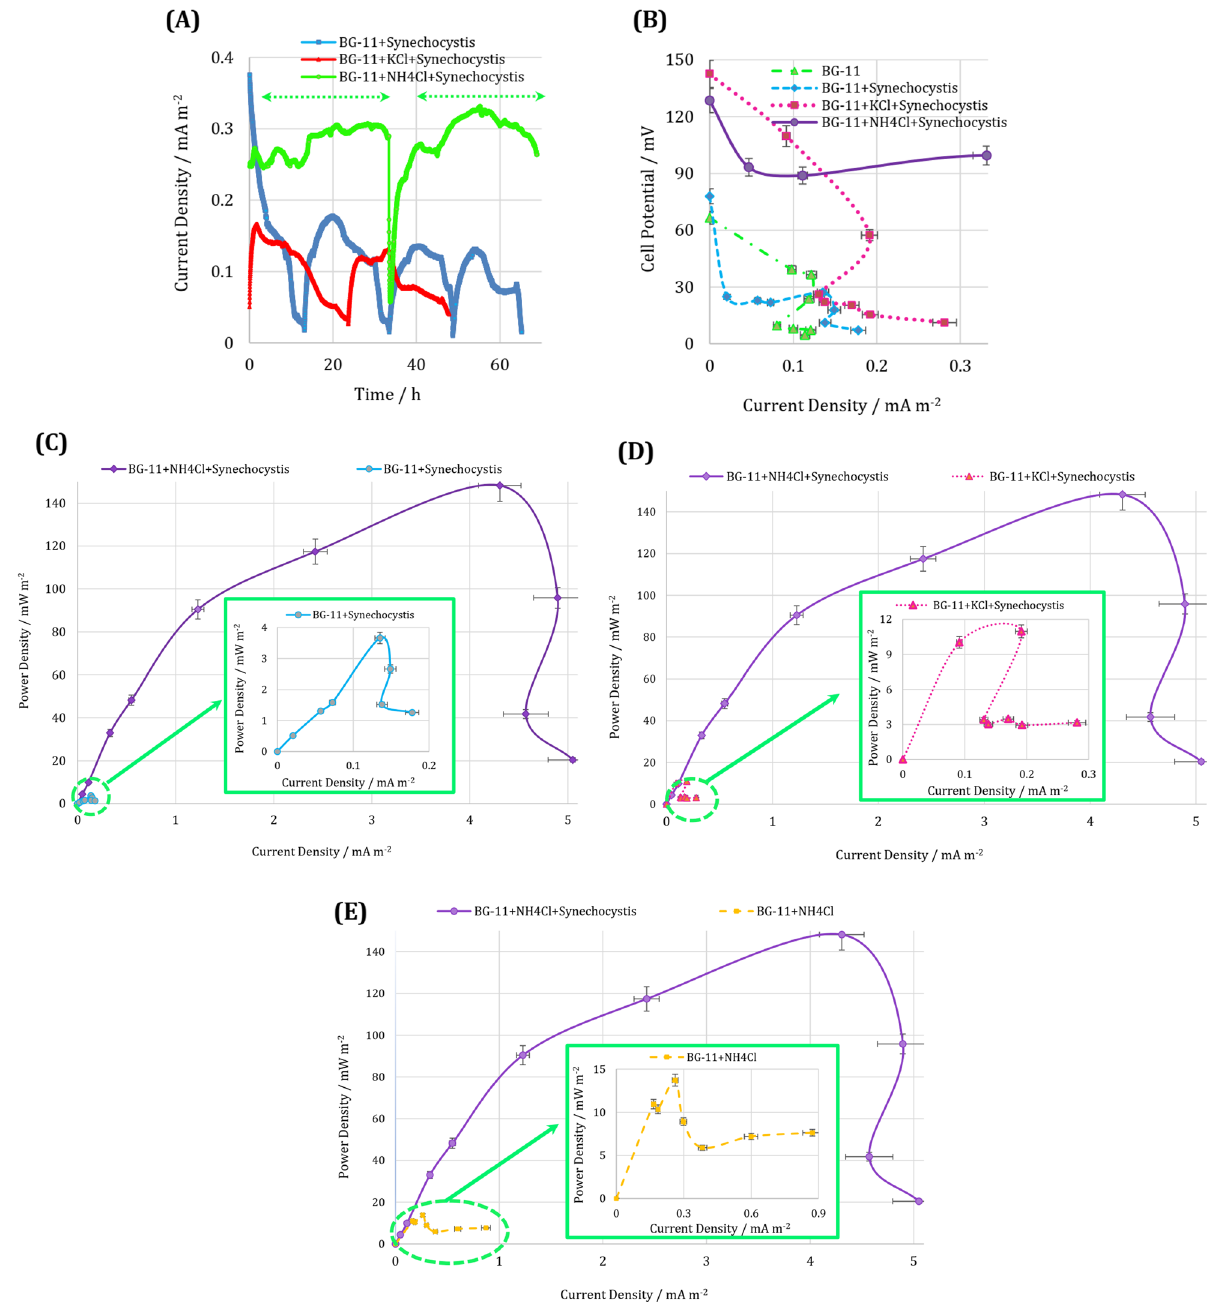
Figure 5. ( A ) The current evolution, ( B ) polarization and ( C ), ( D ), and ( E ) power density curves for different culture media. The error bars represent the variation of obtained results among repeated Additionally, the stationary phase in the current evolution (shown by two dashed horizontal arrows in Fig. 5A) of the BG-11 + NH 4 Cl fed BPV was longer compared to the BPV cultured BG-11 and BG-11 + KCl, indicating a stable current density by extension feed replacement. The BPV overpotentials (including activation, ohmic, and concentration) can be investigated by applying different external resistances to polarize the cell. The polarization curves of four types of BPV feed was illus- trated in Fig. 5B. The abrupt reductions of cell potentials in the polarization curves of BG-11 + Synechocystis and BG-11 + KCl + Synechocystis indicate the high activation overpotential to extract the electron from the cellular metabolism. This type of overpotential was remarkably higher than two other overpotentials (i.e., ohmic and con- centration overpotentials) characterized at the middle and end of polarization curves. Activation overpotential represents the energy that microbes required to transfer electrons from their surface to the electrode 33 . These high drops corroborate the hypothesis presented in previous researches 5,9 , indicating the incapability of Synechocystis to transfer electrons from its membrane due to the competition of numerous metabolic pathways for energy